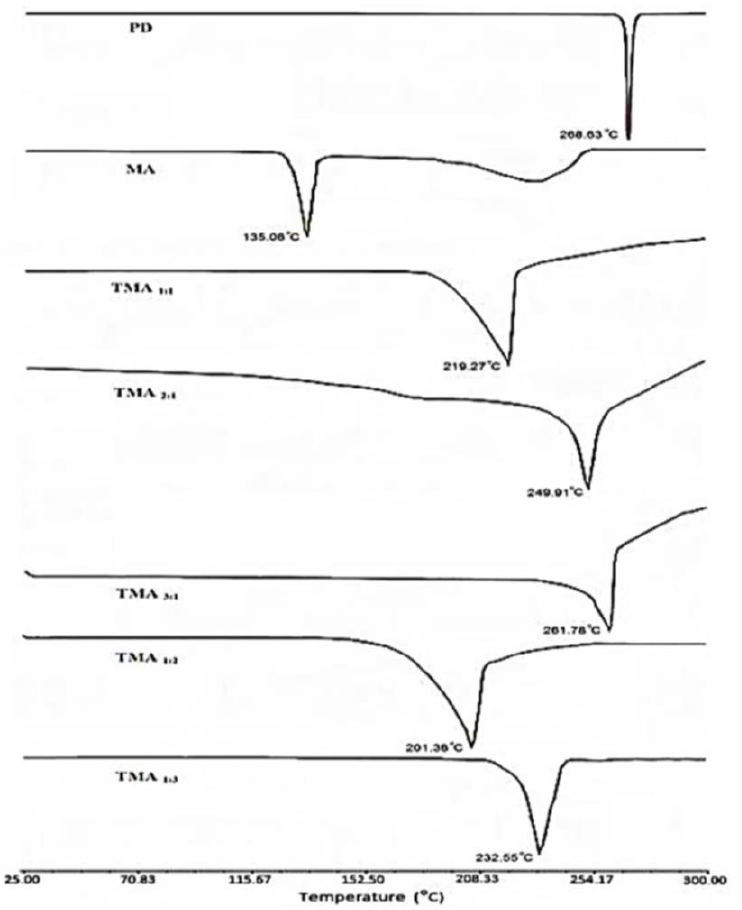
Figure 9. DSC thermogram of telmisartan (PD), maleic acid (MA), and prepared telmisartan-maleic acid cocrystals.